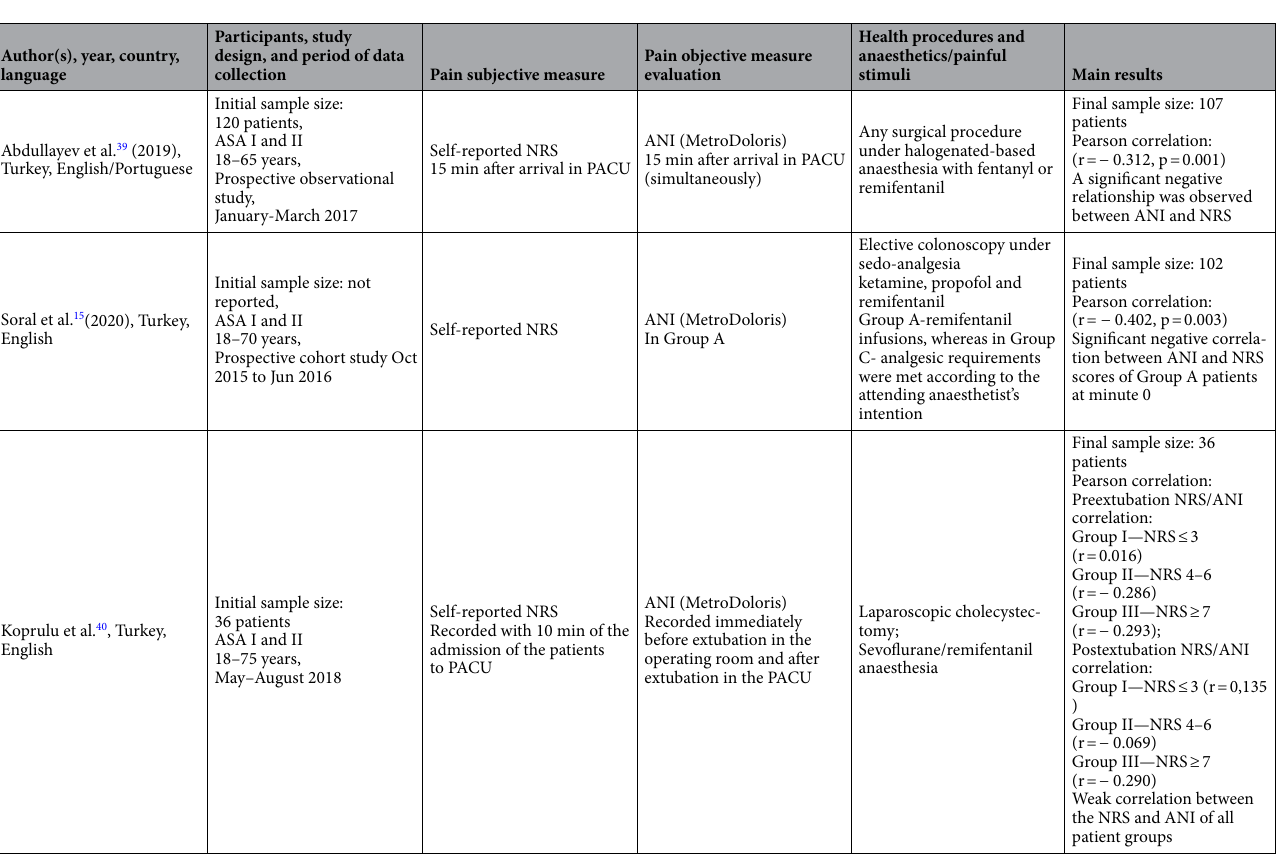
Table 1. Summary of characteristics and results of the included studies. ANI Analgesia Nociception Index, ASA American Society of Anesthesiologists, AUC area under the curve, CI confidence interval, NPV negative predictive value, NRS numerical rating scale, PACU post-anesthesia care unit, PLR pupillary light reflex, PPV positive predictive value, ROC receiver operating characteristics, SD standard deviation, SE standard error, SEM standard error of the mean, SPI surgical plethysmographic index, VAS visual analogue scale, VCPD variation coefficient of pupillary